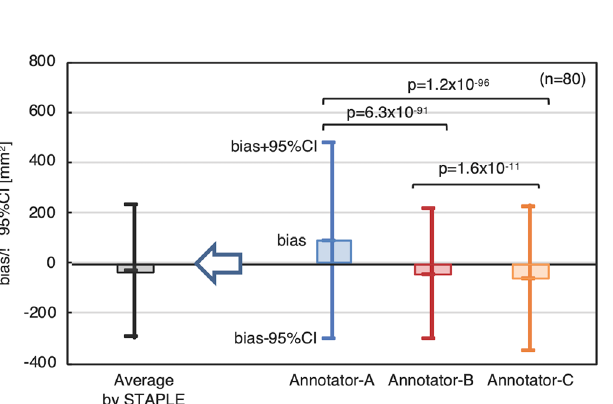
Figure 2. Plot of centroid distances. Limit of agreement is shown as 20 mm, which is approximately half the diameter of a flattened retina.